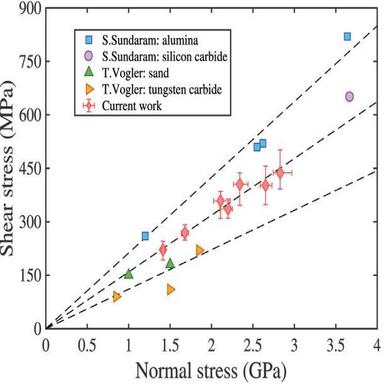
Pressure dependence of shear stress from comparison with data from literature (LaJeunesse, 2018; Sundaram, 1998; Vogler et al., 2011). The blue dots are for spherical alumina powder with average particle size at 400 nm and the purple dot is for silicon carbide powder, which is similar to our material in terms of particle shape. Green and yellow dots are data points for tungsten carbide powder and sand with larger particle size. (For interpretation of the references to color in this figure lege